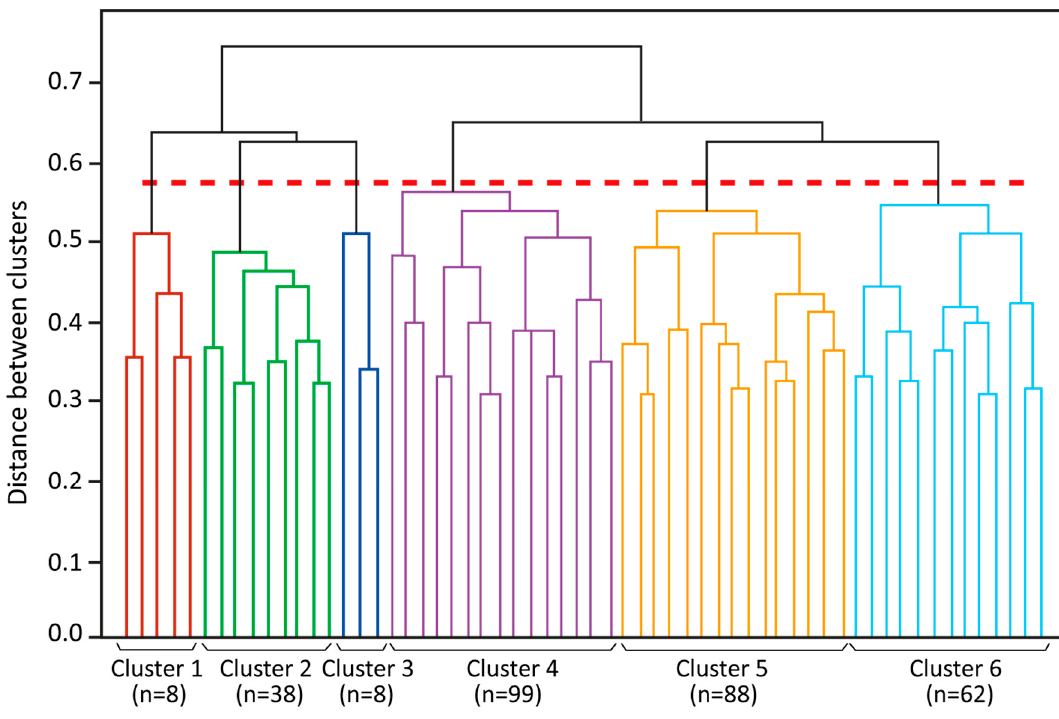
Figure 2. Clustering dendrogram.